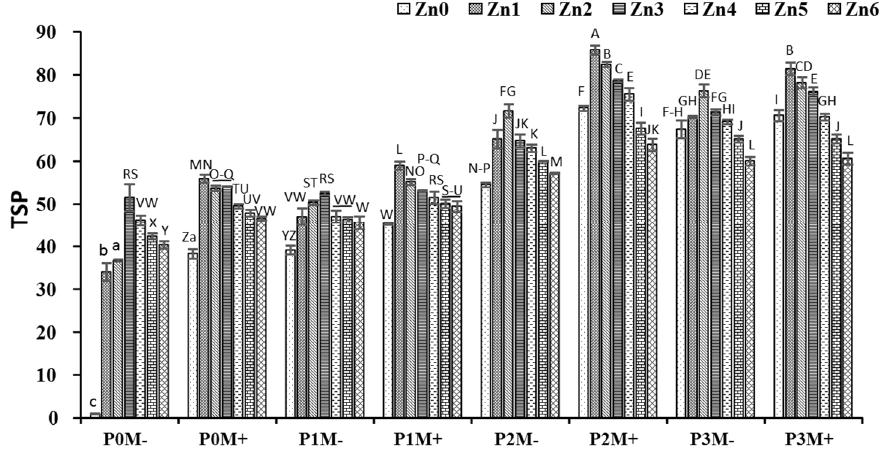
Figure 3. Total soluble protein in maize grown under various P (0, quarter, half, and full recom- mended dose) and Zn (0, 20, 40, 60, 80, 100 and 120 mg Zn/kg soil) application rates under AM and NM conditions. Mean values are presented ± standard error (SE). Different letters on the bars indicate significant differences at p ≤ 0.05. Capital letters indicate the highest values. After completely using upper case letters up to Z, lower case letters are used to show the decrease of mean values. P1 = 14.5 kg, P2 = 29 kg, P3 = 58 kg; Zn control = 0, Zn1 = 20, Zn2 = 40, Zn3 = 60, Zn4 = 80, Zn5 = 100, and Zn6 = 120 mg Zn kg − 1 .